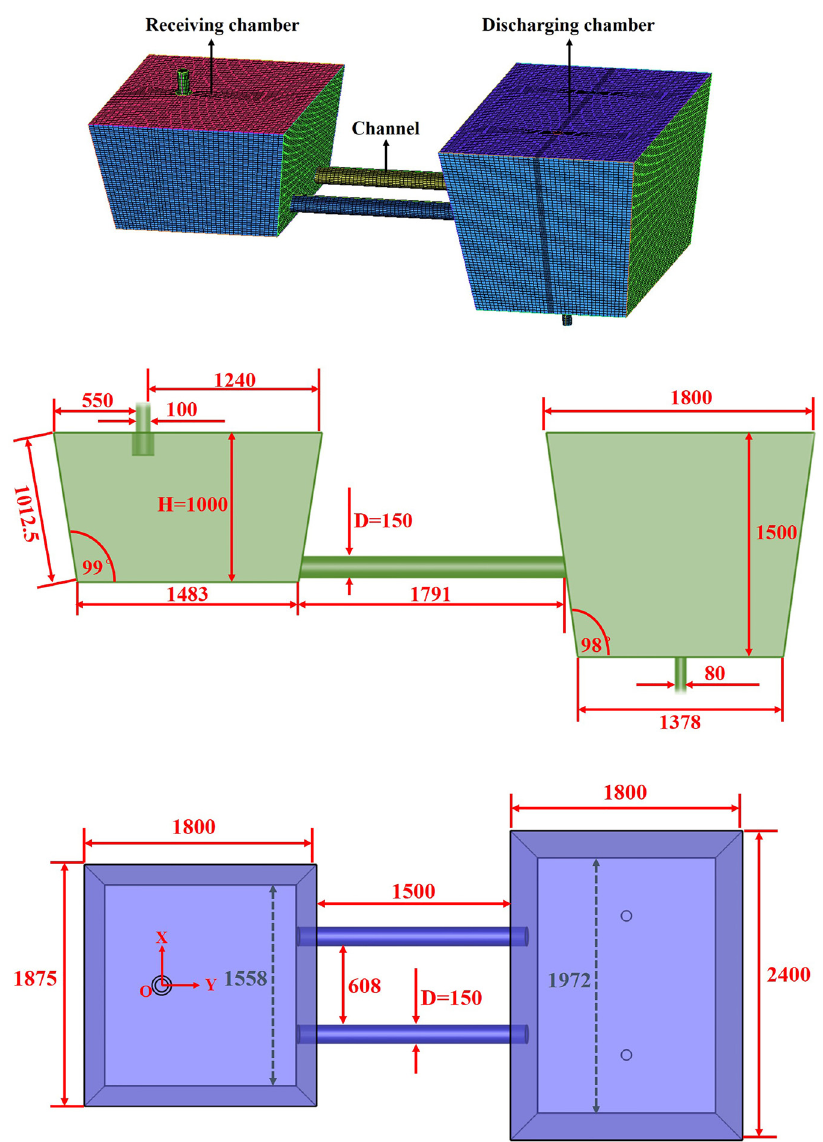
Figure 1: Schematic of tundish with channel - type induction heating ( all lengths are in mm )